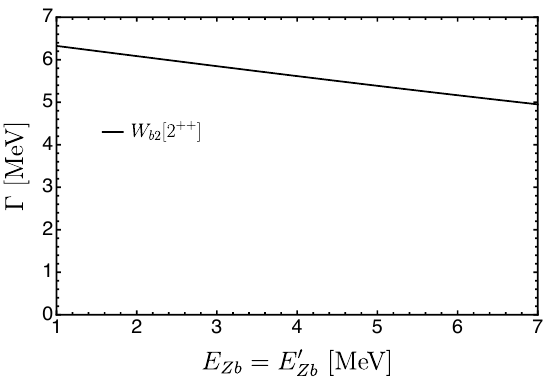
Figure 4 . The decay width of the W b 2 (2 ++ ) state from coupled-channel transitions B (cid:3) (cid:22) B (cid:3) ! B (cid:22) B and B (cid:3) (cid:22) B (cid:3) ! B (cid:22) B (cid:3) evaluated in the full theory, including the OPE and